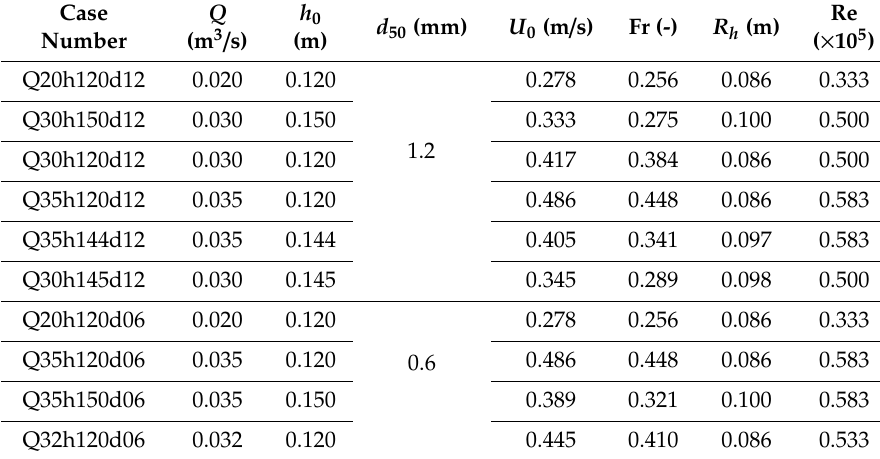
Figure 5. Preparation of scour test with movable bed and water supply. Table 1. Hydraulic conditions of